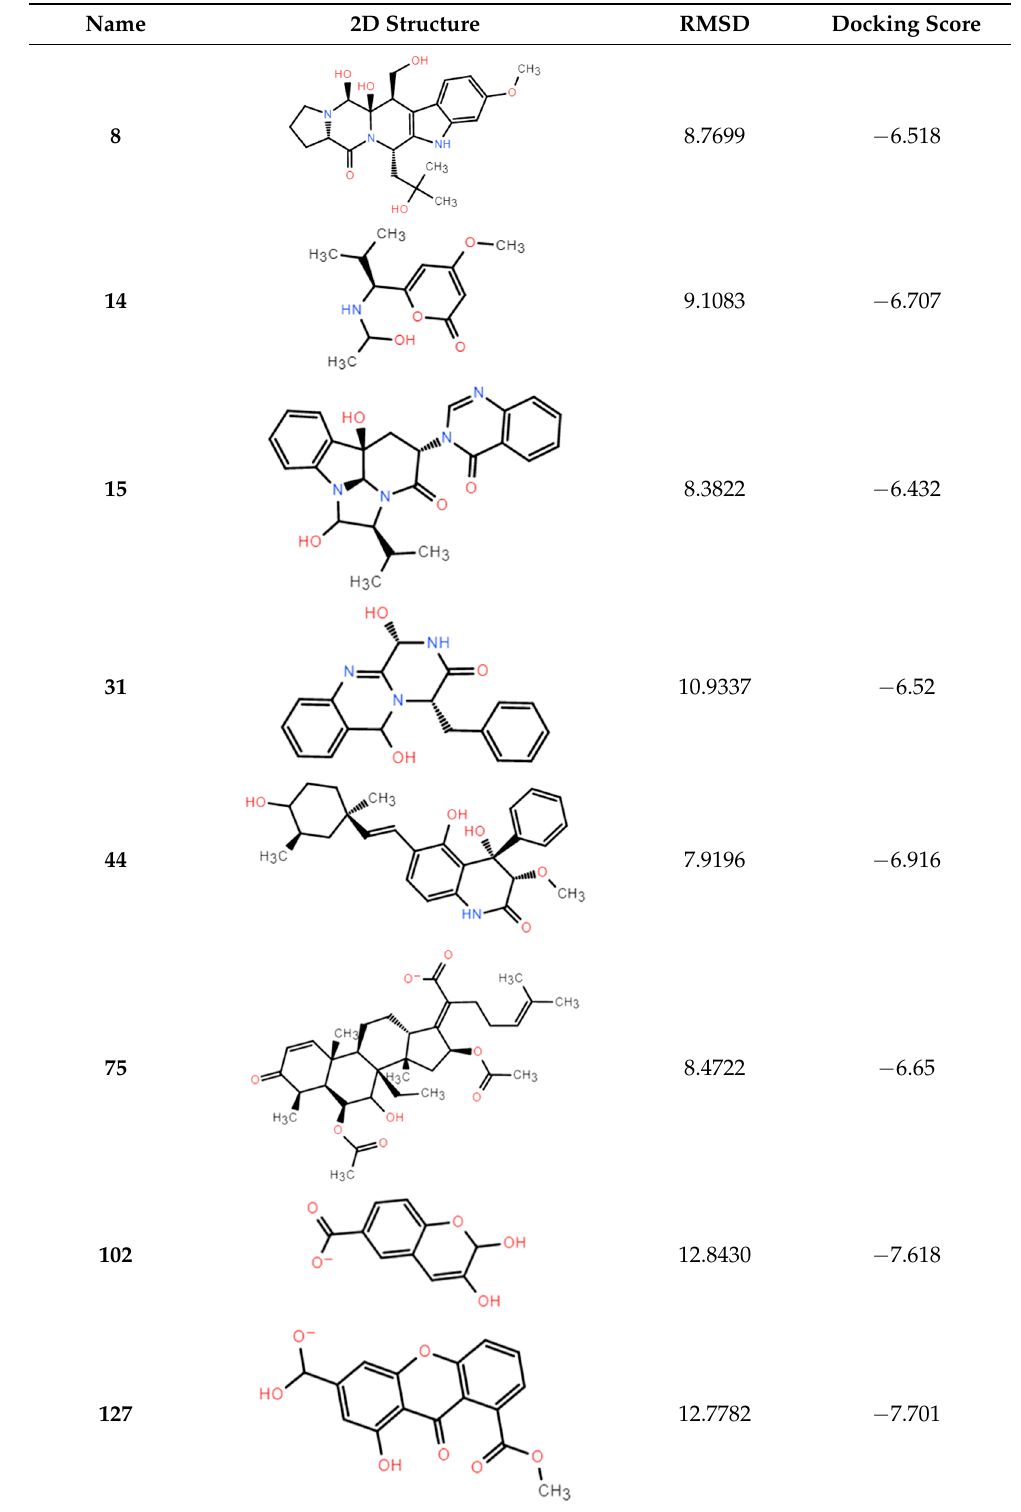
Table 3. Docking RMSD between ligand pose and crystal coordinates for compounds with better docking results than positive controls.